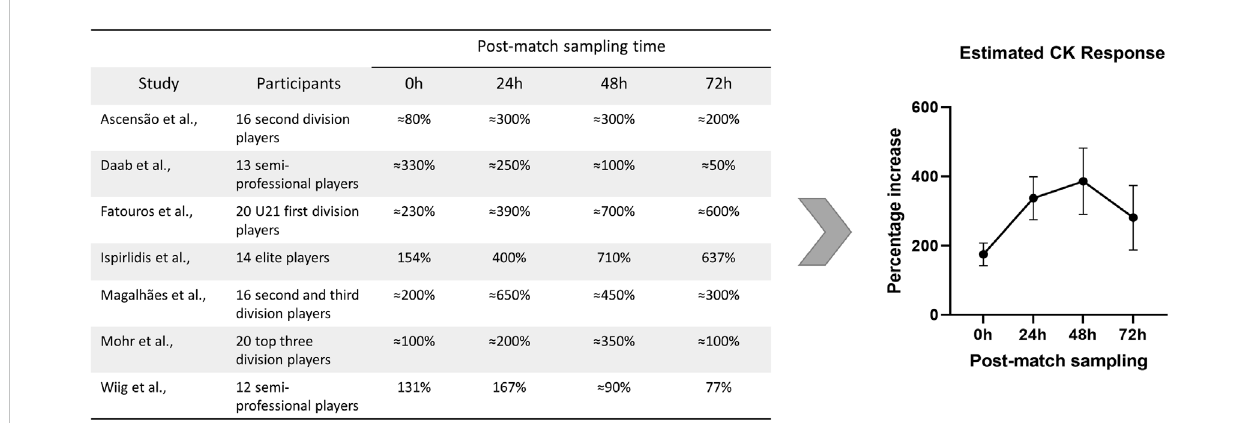
FIGURE 2 Data from studies reporting percentage increases in circulating CK levels of male football players during post-match recovery. Data presented as percentage increase during recovery compared with pre-match values. The estimation of the average CK response was calculated by pooling CK percentage increases as mean ±SEM at the different time-points. CK, creatine kinase; SEM, standard error of the mean. Citations: (Ascensao et al., 2008; Daab et al., 2021; Fatouros et al., 2010; Ispirlidis et al., 2008; Magalhães et al., 2010; Mohr et al., 2016; Wiig et al.,